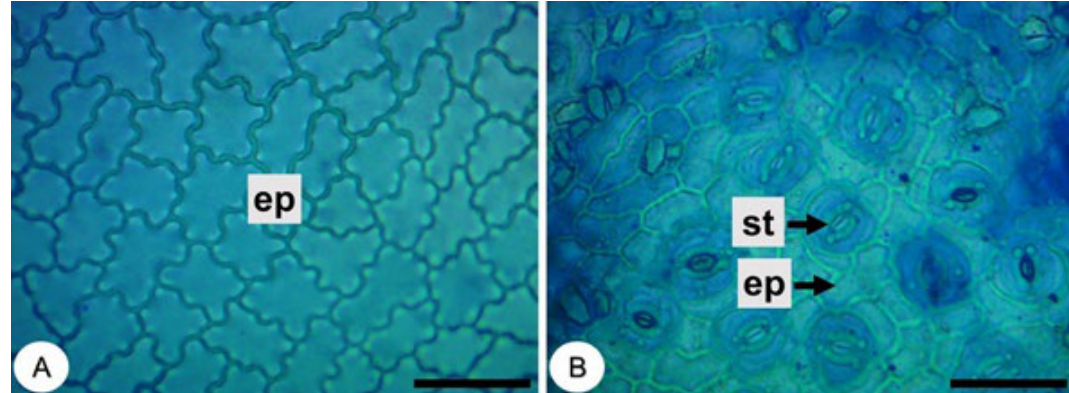
FIGURE 3 - Frontal view of the leaf blade of Manilkara zapota (L.) P.Royen (Sapotaceae). A: Adaxial surface. B: Abaxial surface. Abbreviations: ep = epidermis; st = stomata. Bars: A, B = 50